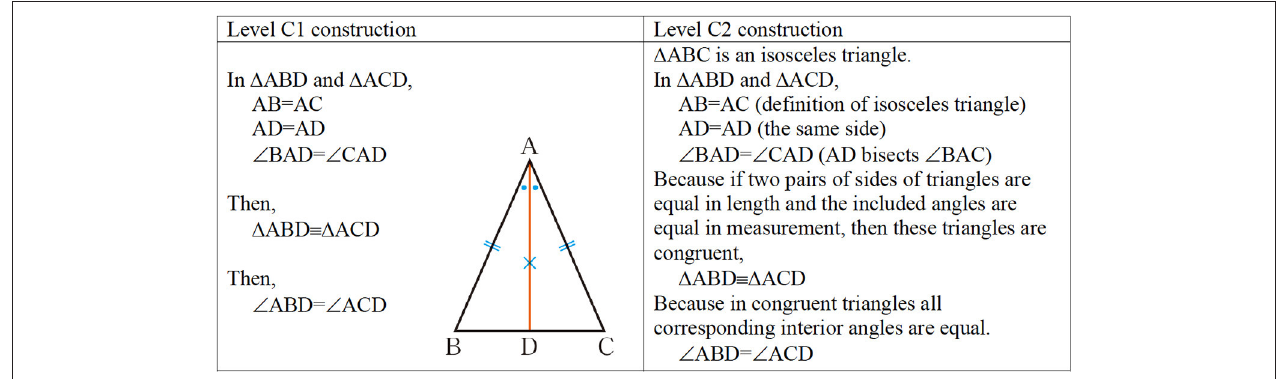
FIGURE 3 | Examples of the learning levels of constructing a proof.